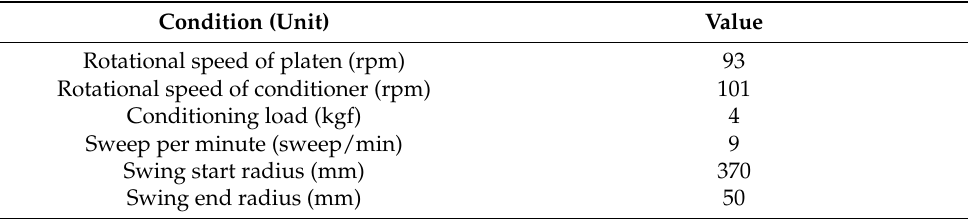
Table 1. Conditions for CMP